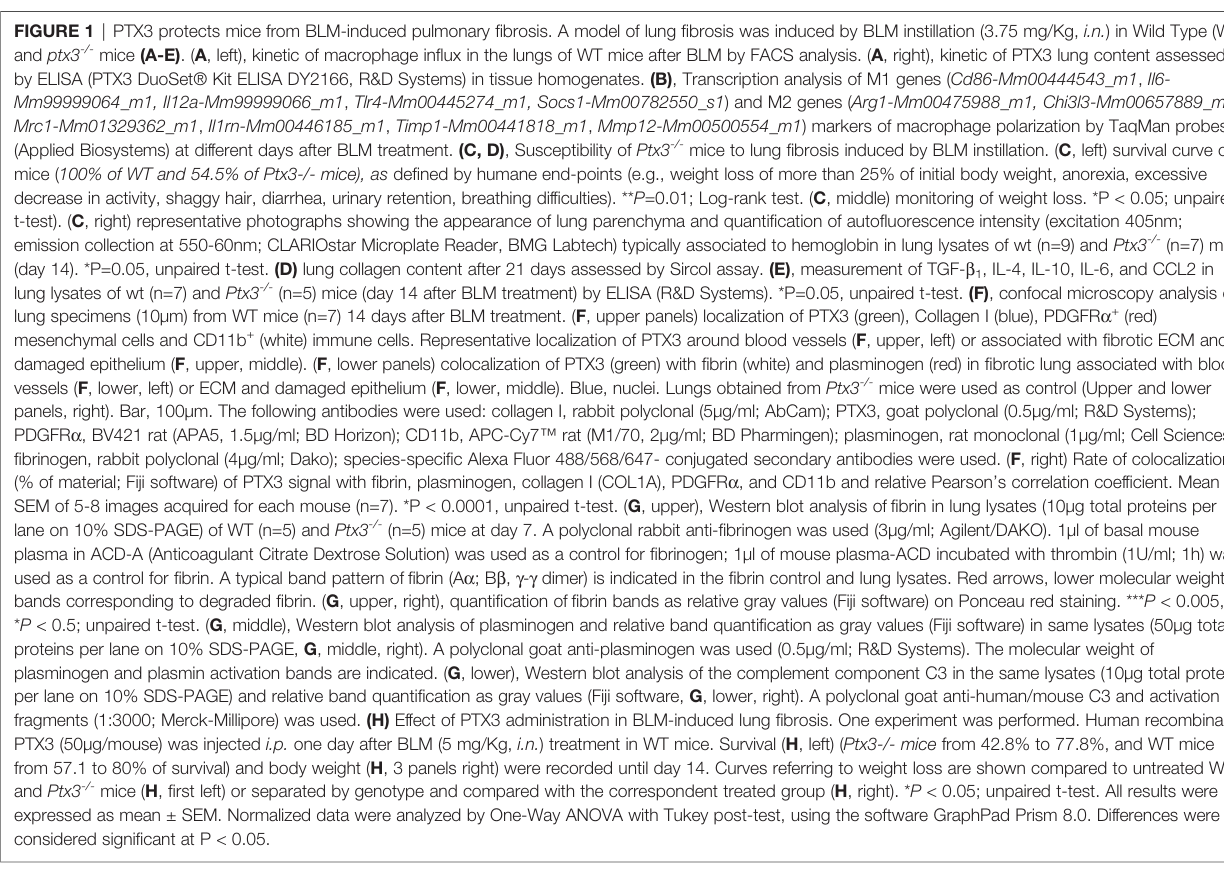
FIGURE 1 | PTX3 protects mice from BLM-induced pulmonary fi brosis. A model of lung fi brosis was induced by BLM instillation (3.75 mg/Kg, i.n. ) in Wild Type (WT) and ptx3 -/- mice (A-E) . ( A , left), kinetic of macrophage in fl ux in the lungs of WT mice after BLM by FACS analysis. ( A , right), kinetic of PTX3 lung content assessed by ELISA (PTX3 DuoSet® Kit ELISA DY2166, R&D Systems) in tissue homogenates. (B) , Transcription analysis of M1 genes ( Cd86-Mm00444543_m1 , Il6- Mm99999064_m1, Il12a-Mm99999066_m1 , Tlr4-Mm00445274_m1, Socs1-Mm00782550_s1 ) and M2 genes ( Arg1-Mm00475988_m1, Chi3l3-Mm00657889_mH , Mrc1-Mm01329362_m1 , Il1rn-Mm00446185_m1 , Timp1-Mm00441818_m1 , Mmp12-Mm00500554_m1 ) markers of macrophage polarization by TaqMan probes (Applied Biosystems) at different days after BLM treatment. (C, D) , Susceptibility of Ptx3 -/- mice to lung fi brosis induced by BLM instillation. ( C , left) survival curve of mice ( 100% of WT and 54.5% of Ptx3-/- mice), as de fi ned by humane end-points (e.g., weight loss of more than 25% of initial body weight, anorexia, excessive decrease in activity, shaggy hair, diarrhea, urinary retention, breathing dif fi culties). ** P =0.01; Log-rank test. ( C , middle) monitoring of weight loss. *P < 0.05; unpaired t-test). ( C , right) representative photographs showing the appearance of lung parenchyma and quanti fi cation of auto fl uorescence intensity (excitation 405nm; emission collection at 550-60nm; CLARIOstar Microplate Reader, BMG Labtech) typically associated to hemoglobin in lung lysates of wt (n=9) and Ptx3 -/- (n=7) mice (day 14). *P=0.05, unpaired t-test. (D) lung collagen content after 21 days assessed by Sircol assay. (E) , measurement of TGF- b 1 , IL-4, IL-10, IL-6, and CCL2 in lung lysates of wt (n=7) and Ptx3 -/- (n=5) mice (day 14 after BLM treatment) by ELISA (R&D Systems). *P=0.05, unpaired t-test. (F) , confocal microscopy analysis on lung specimens (10µm) from WT mice (n=7) 14 days after BLM treatment. ( F , upper panels) localization of PTX3 (green), Collagen I (blue), PDGFR a + (red) mesenchymal cells and CD11b + (white) immune cells. Representative localization of PTX3 around blood vessels ( F , upper, left) or associated with fi brotic ECM and damaged epithelium ( F , upper, middle). ( F , lower panels) colocalization of PTX3 (green) with fi brin (white) and plasminogen (red) in fi brotic lung associated with blood vessels ( F , lower, left) or ECM and damaged epithelium ( F , lower, middle). Blue, nuclei. Lungs obtained from Ptx3 -/- mice were used as control (Upper and lower panels, right). Bar, 100µm. The following antibodies were used: collagen I, rabbit polyclonal (5µg/ml; AbCam); PTX3, goat polyclonal (0.5µg/ml; R&D Systems); PDGFR a , BV421 rat (APA5, 1.5µg/ml; BD Horizon); CD11b, APC-Cy7 ™ rat (M1/70, 2µg/ml; BD Pharmingen); plasminogen, rat monoclonal (1µg/ml; Cell Sciences); fi brinogen, rabbit polyclonal (4µg/ml; Dako); species-speci fi c Alexa Fluor 488/568/647- conjugated secondary antibodies were used. ( F , right) Rate of colocalization (% of material; Fiji software) of PTX3 signal with fi brin, plasminogen, collagen I (COL1A), PDGFR a , and CD11b and relative Pearson ’ s correlation coef fi cient. Mean ± SEM of 5-8 images acquired for each mouse (n=7). *P < 0.0001, unpaired t-test. ( G , upper), Western blot analysis of fi brin in lung lysates (10µg total proteins per lane on 10% SDS-PAGE) of WT (n=5) and Ptx3 -/- (n=5) mice at day 7. A polyclonal rabbit anti- fi brinogen was used (3µg/ml; Agilent/DAKO). 1µl of basal mouse plasma in ACD-A (Anticoagulant Citrate Dextrose Solution) was used as a control for fi brinogen; 1µl of mouse plasma-ACD incubated with thrombin (1U/ml; 1h) was used as a control for fi brin. A typical band pattern of fi brin (A a ; B b , g - g dimer) is indicated in the fi brin control and lung lysates. Red arrows, lower molecular weight bands corresponding to degraded fi brin. ( G , upper, right), quanti fi cation of fi brin bands as relative gray values (Fiji software) on Ponceau red staining. *** P < 0.005, * P < 0.5; unpaired t-test. ( G , middle), Western blot analysis of plasminogen and relative band quanti fi cation as gray values (Fiji software) in same lysates (50µg total proteins per lane on 10% SDS-PAGE, G , middle, right). A polyclonal goat anti-plasminogen was used (0.5µg/ml; R&D Systems). The molecular weight of plasminogen and plasmin activation bands are indicated. ( G , lower), Western blot analysis of the complement component C3 in the same lysates (10µg total proteins per lane on 10% SDS-PAGE) and relative band quanti fi cation as gray values (Fiji software, G , lower, right). A polyclonal goat anti-human/mouse C3 and activation fragments (1:3000; Merck-Millipore) was used. (H) Effect of PTX3 administration in BLM-induced lung fi brosis. One experiment was performed. Human recombinant PTX3 (50µg/mouse) was injected i.p. one day after BLM (5 mg/Kg, i.n. ) treatment in WT mice. Survival ( H , left) ( Ptx3-/- mice from 42.8% to 77.8%, and WT mice from 57.1 to 80% of survival) and body weight ( H , 3 panels right) were recorded until day 14. Curves referring to weight loss are shown compared to untreated WT and Ptx3 -/- mice ( H , fi rst left) or separated by genotype and compared with the correspondent treated group ( H , right). * P < 0.05; unpaired t-test. All results were expressed as mean ± SEM. Normalized data were analyzed by One-Way ANOVA with Tukey post-test, using the software GraphPad Prism 8.0. Differences were considered signi fi cant at P <